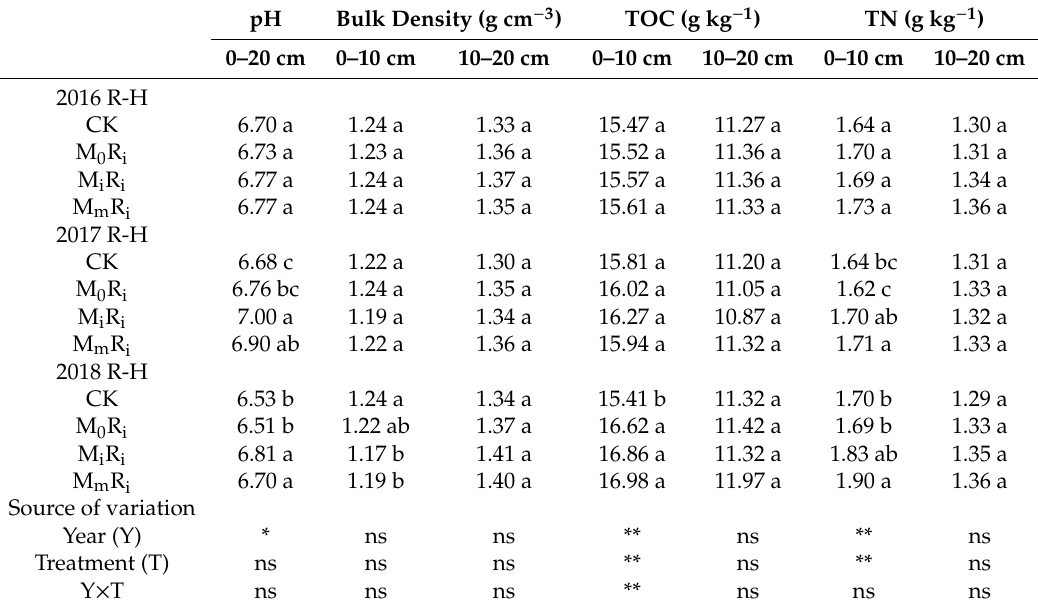
Table 2. Changes in pH, bulk density, TOC, and TN under di ff erent straw incorporation treatments. pH